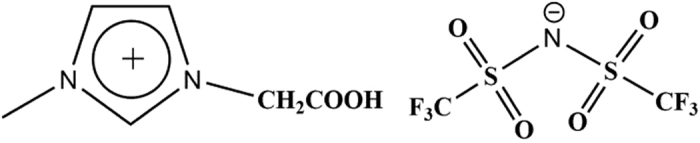
Chemical structure of [HOOCmim][NTf2].